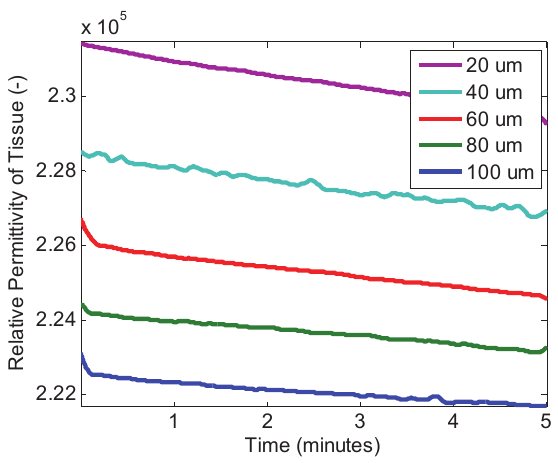
Fig. 8: Measured force during small strain indentation experiments on acellular alginate. Legend denotes final indentation depth.